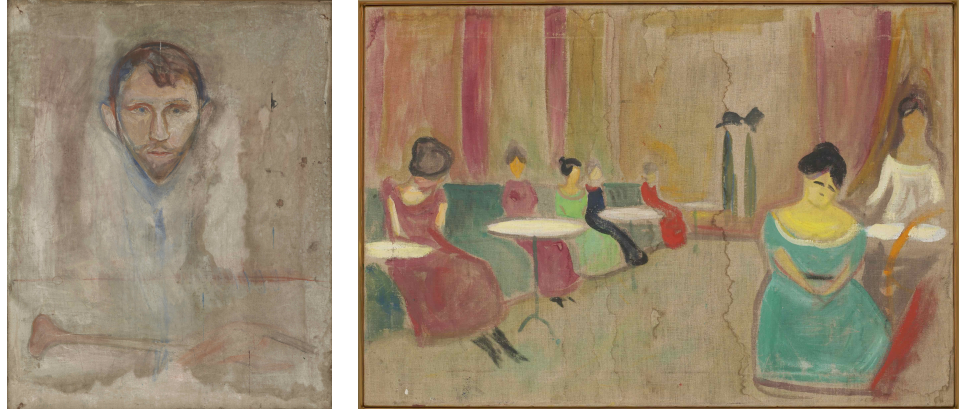
Figure 2: The role of the ground